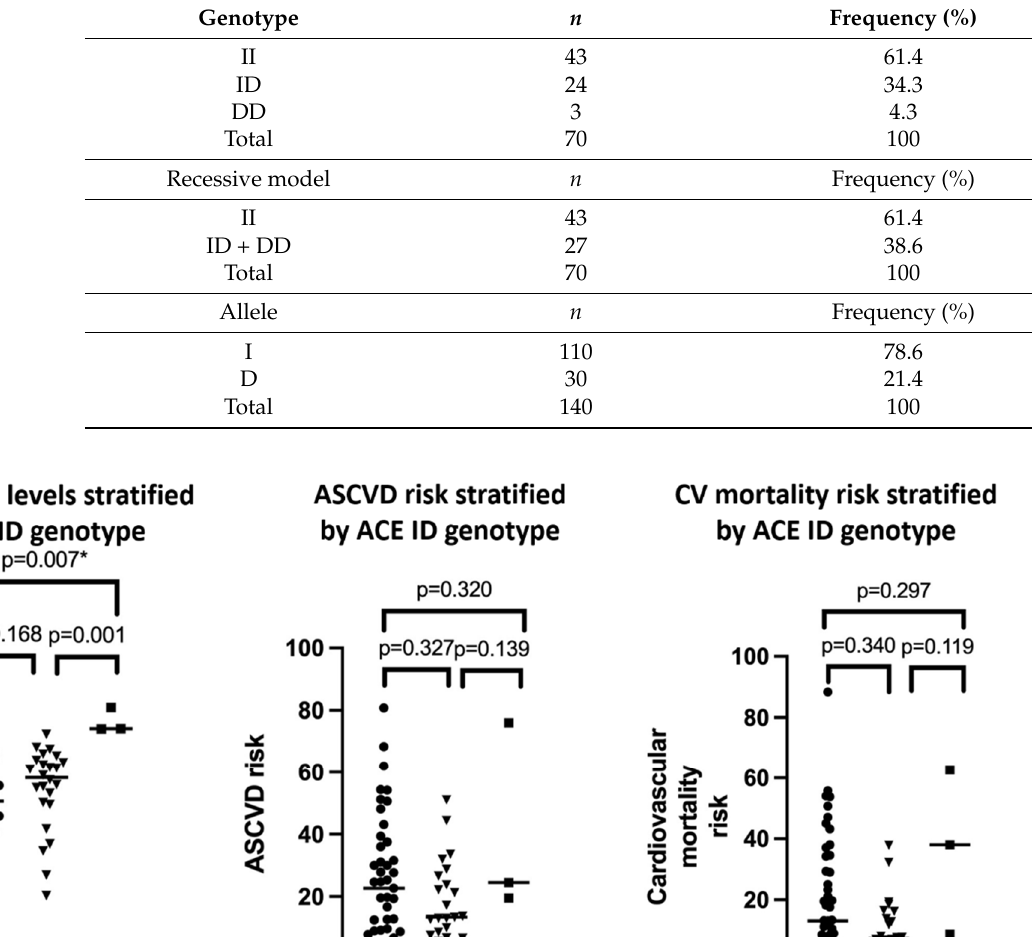
Table 5. Results of ACE I/D genotyping in CKD patients.